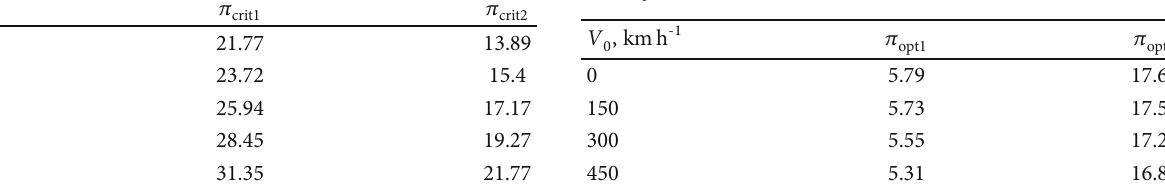
crit1 and Table 6: Variations in optimum compressor pressure ratios π and π opt2 with V 0